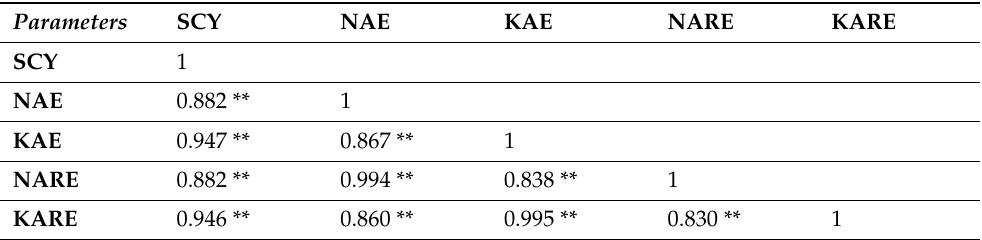
Table 5. Pearson’s correlation matrix for nutrient-use efficiency indices determining nutrient efficiency of cultivars under AWC-50%.